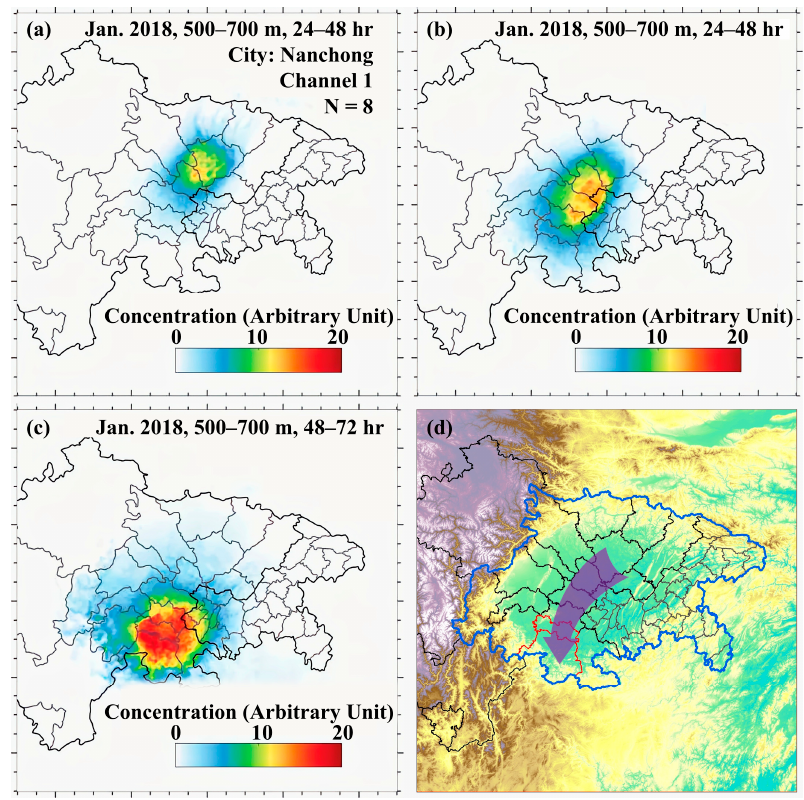
Figure 2. The distributions of tracer particle concentrations between ( a ) 0 and the 24th hour, ( b ) the 24th and 48th hours, ( c ) the 48th and 72nd hours since the release of tracer particles, and ( d ) the identi fi ed transport channel for the fi rst classi fi ed category from clustering analysis in Nanchong.